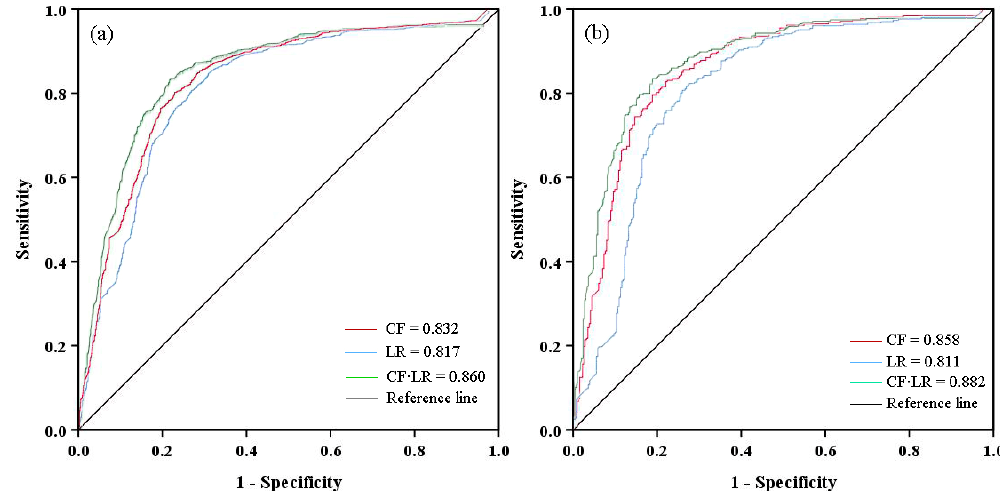
Figure 6. The success-rate and prediction-rate curves for the flash flood map: ( a ) success rate and ( b ) prediction rate.